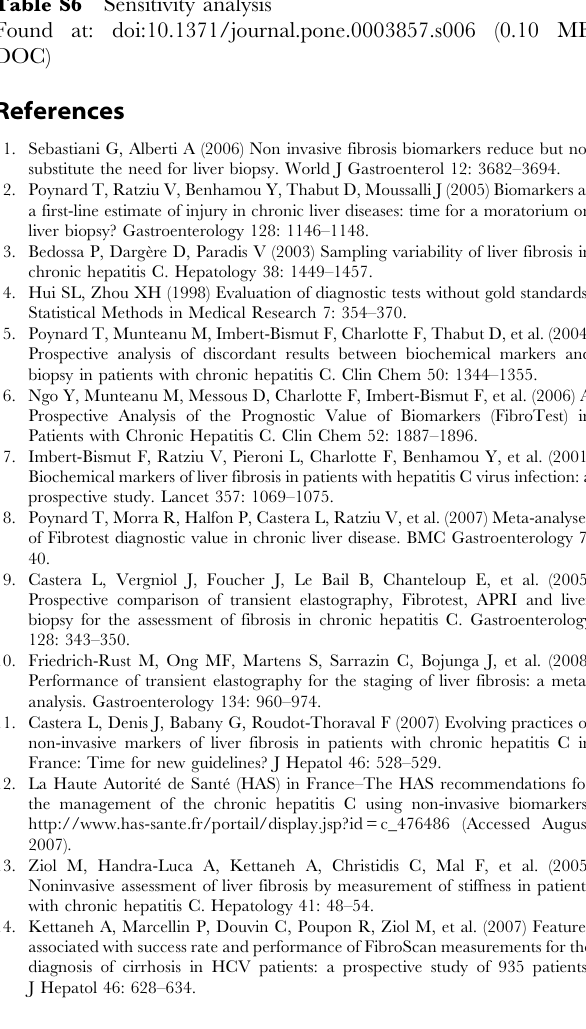
Table S3 Variability factors